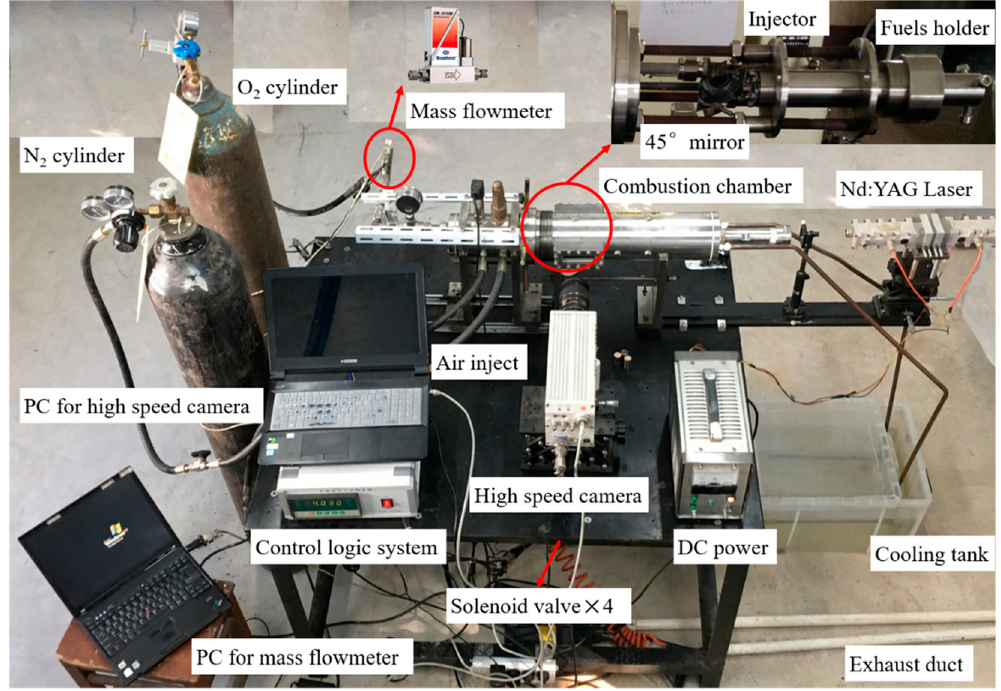
Figure 1. Optical image of the 2D-radial hybrid propulsion burner